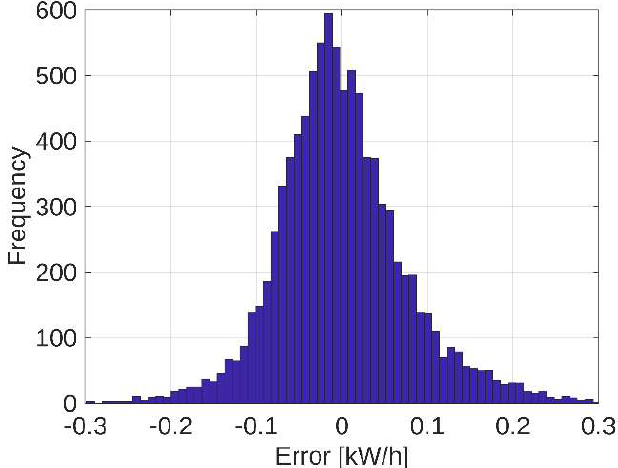
Figure 16. The residual error term of the ECR prediction model.